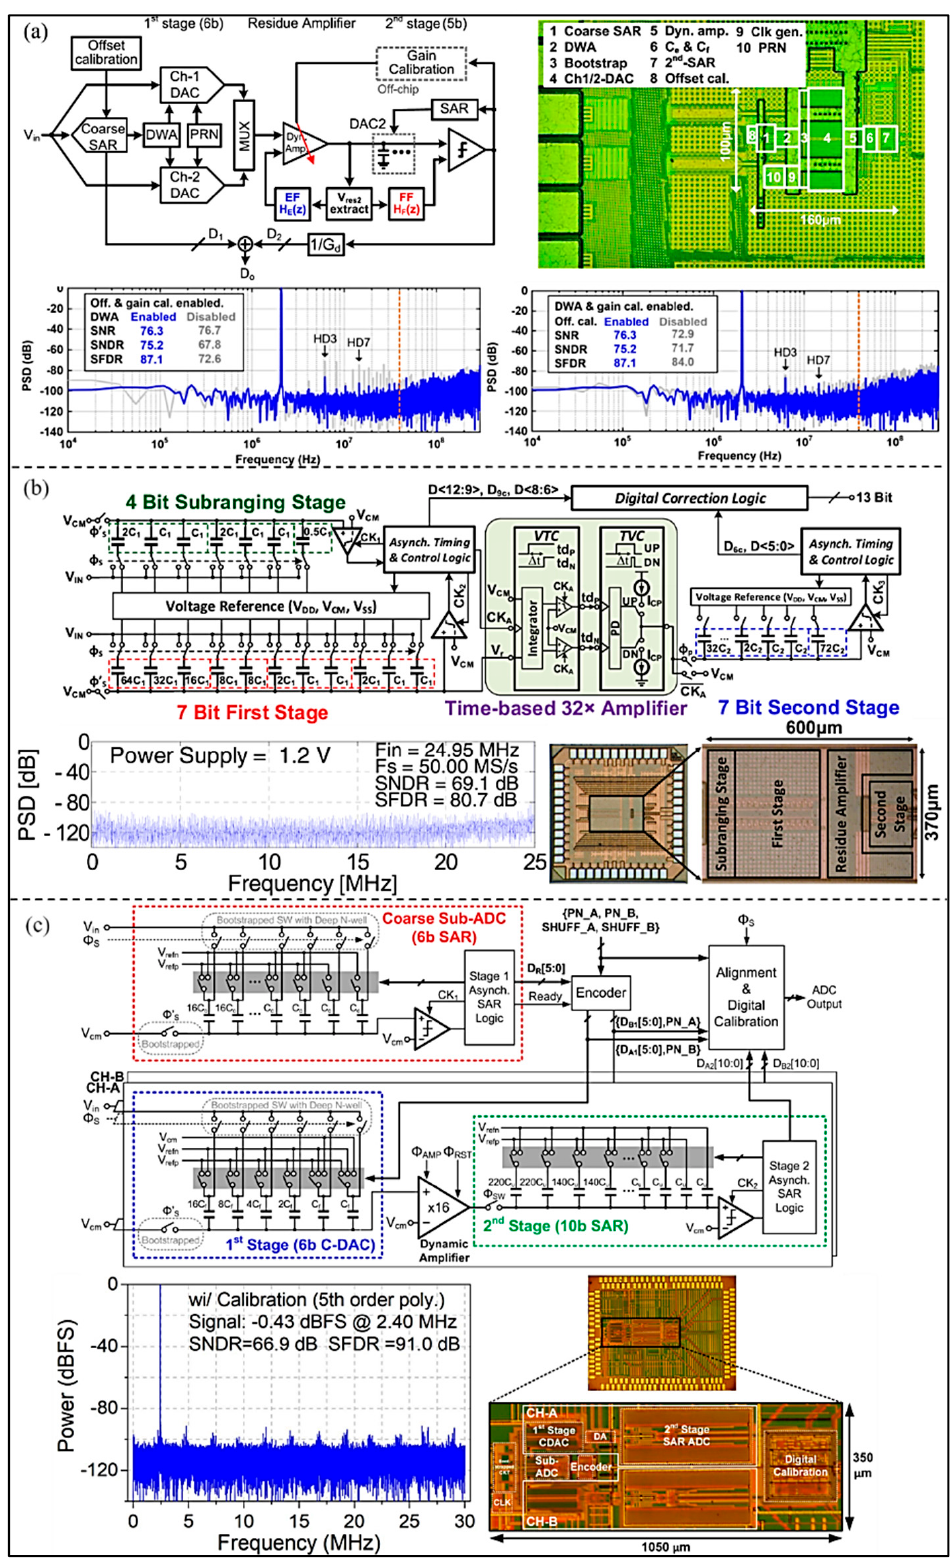
Figure 18. ( a ) Block diagram, layout, and measured results of the proposed ADC. (Reprinted from [67], Copyright 2020, with permission from IEEE); ( b ) Circuit architecture, timing diagram, die, and measured result of the developed ADC. (Reprinted from [68], Copyright 2017, with permission from IEEE); ( c ) Block diagram, layout, and measured results of the proposed ADC. (Reprinted from [69], Copyright 2020, with permission from IEEE).